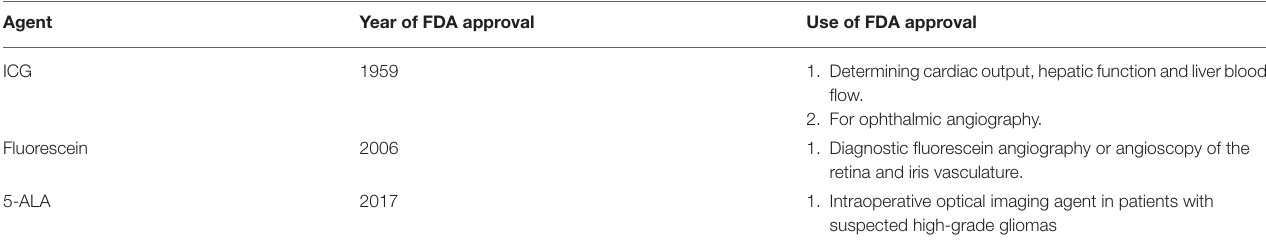
TABLE 2 | Fluorophores currently used in brain tumor surgery and Food and Drug Administration (FDA) use